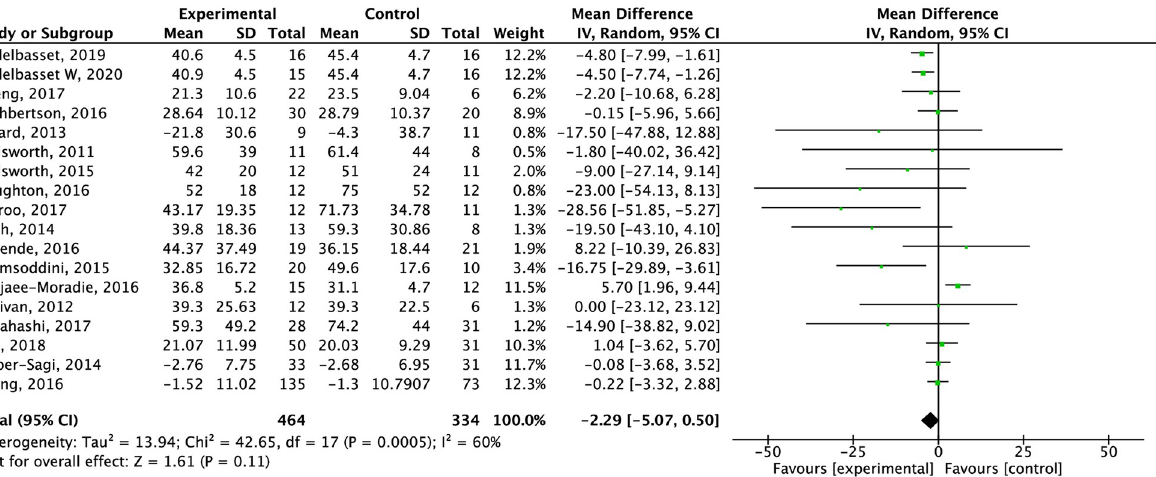
Fig 8. Effect of exercise alone compared to the control group in ALT concentration.